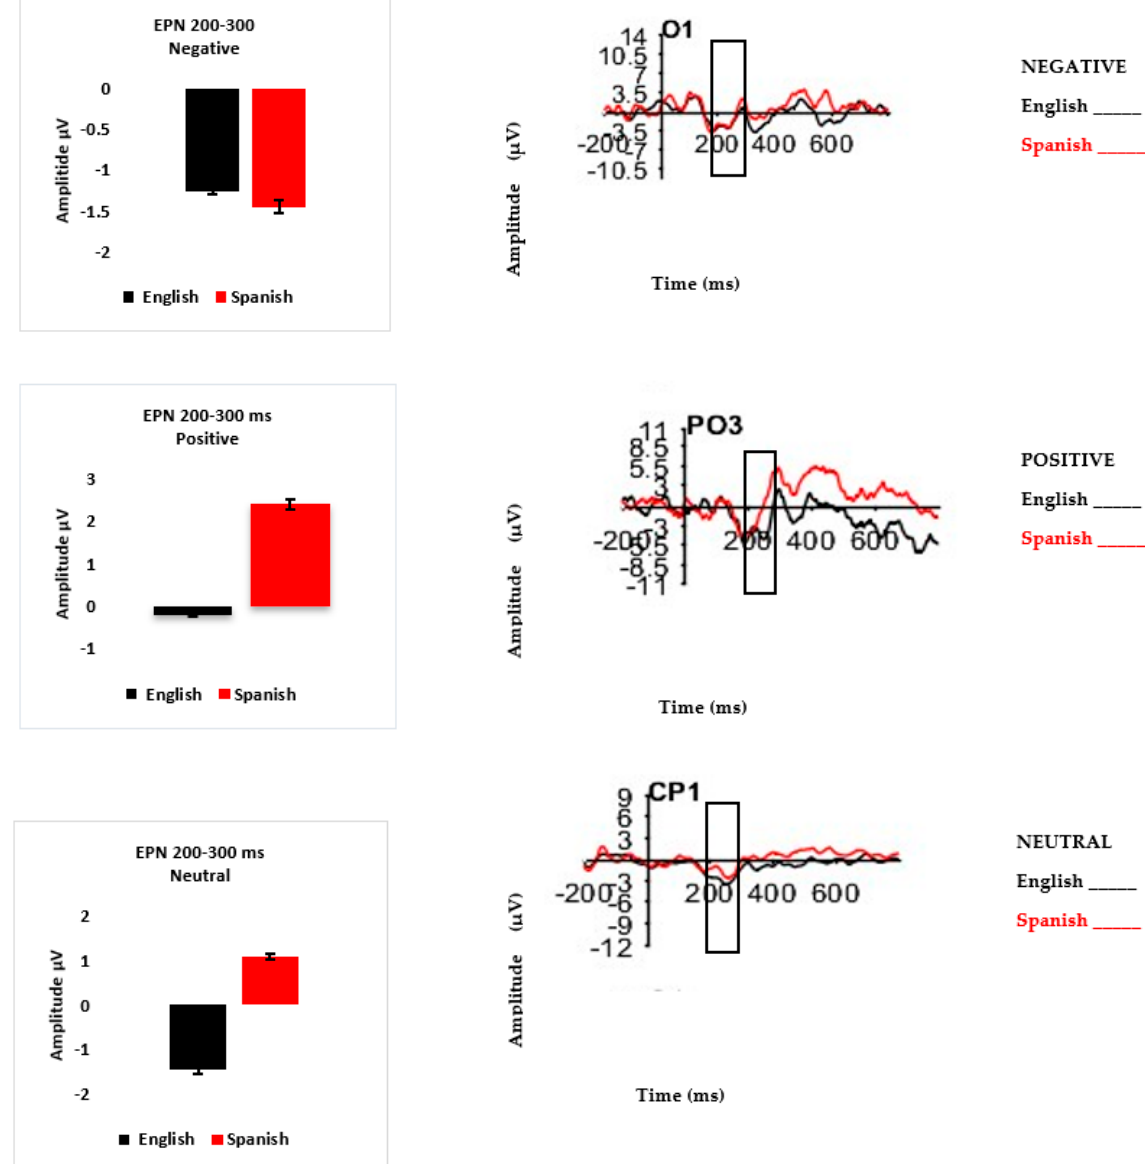
Figure 2. Amplitudes recorded for EPN 200–300 ms as a function of language of the target stimulus and valence. Representative electrodes O1, PO3, and CP1 illustrate differences in the EPN responses between English and Spanish negative, positive, and neutral targets. Bar plots show posterior EPN activity averaged across the posterior electrodes and the entire time window for EPN 200–300 ms. Error bars are standard errors.